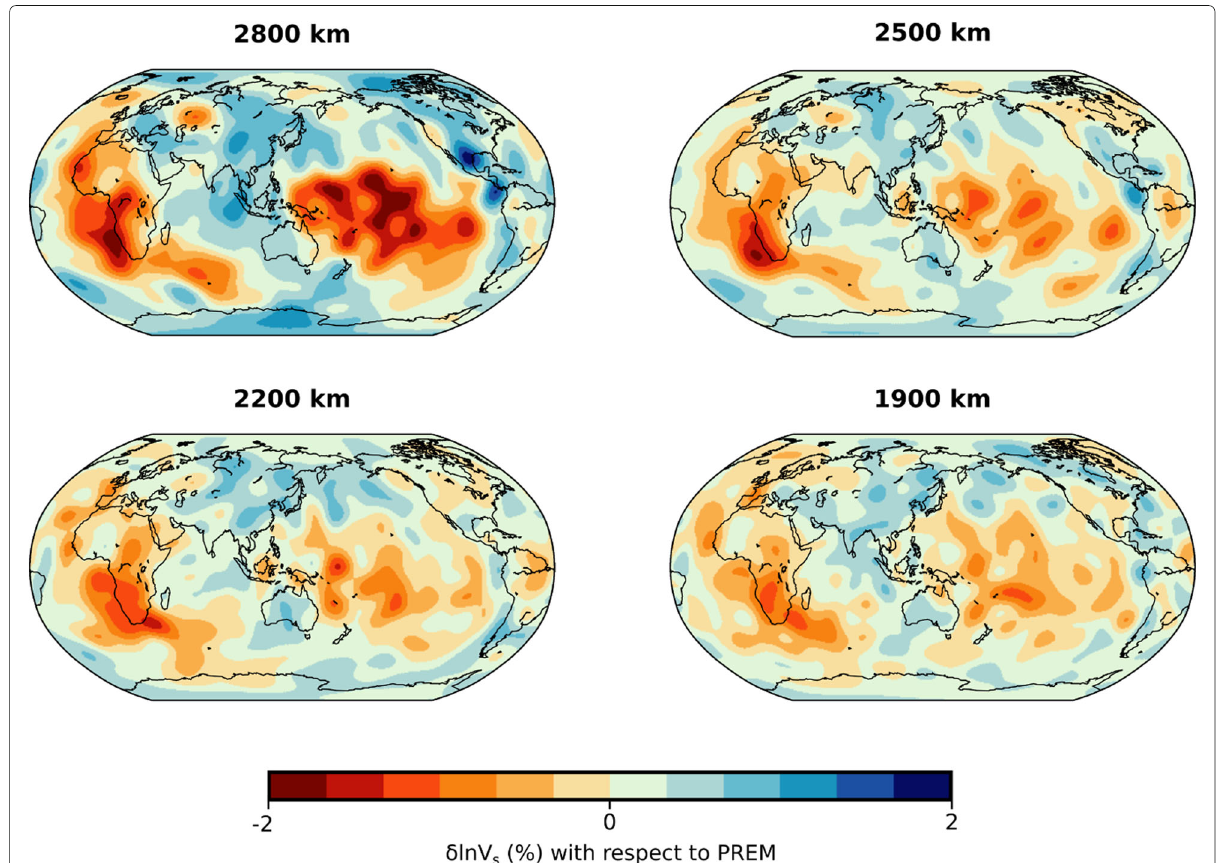
Fig. 1 Depth slices of S40RTS (Ritsema, 2011) showing variations in shear-wave velocity, δ lnV s , with respect to the radial average. Both positive and negative velocity anomalies are highest toward the CMB. The color intensity is proportional to the velocity amplitude up to a maximum value of 2%